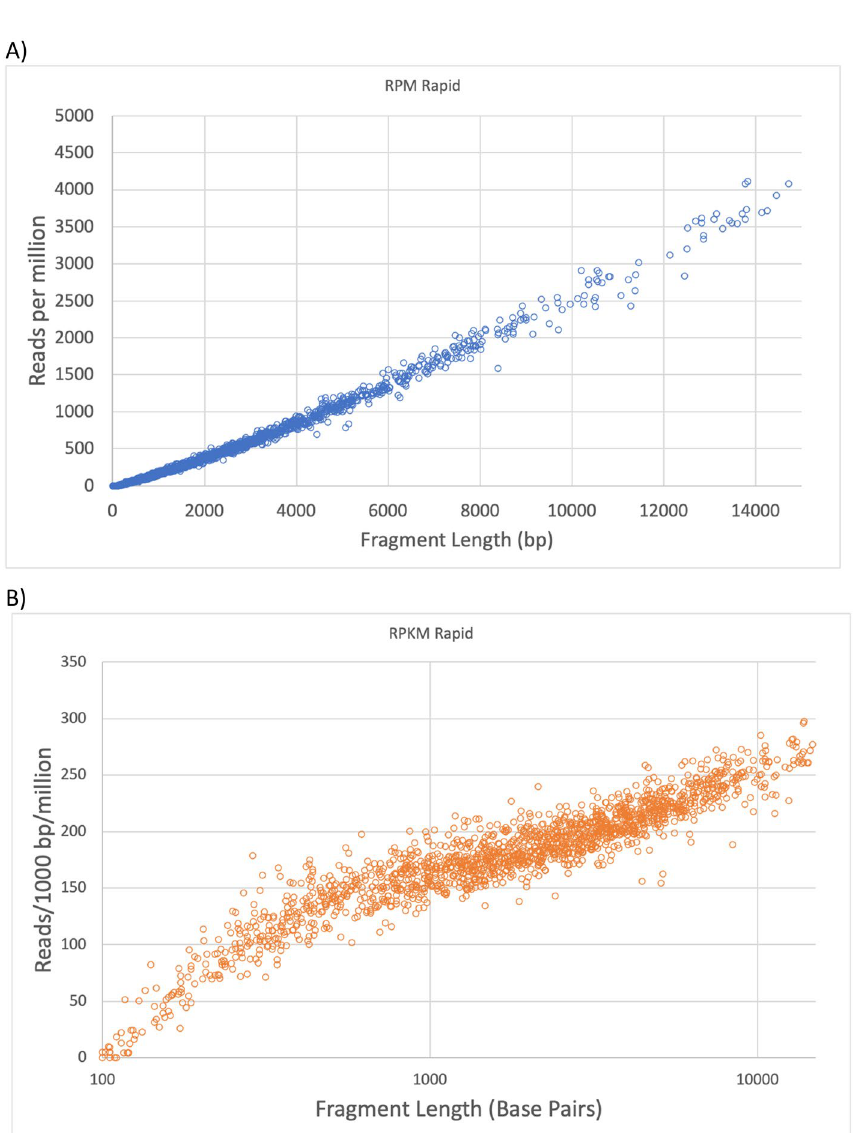
Figure 6. Oxford Nanopore reads using the transposon-based fast library preparation. XmnI-cut E. coli DNA was prepared for sequencing using the standard fast library preparation method. The number of RPM is plotted as a function of predicted DNA length ( A ). The same data set was converted to RKPM to adjust for length and plotted again ( B ) but on a log